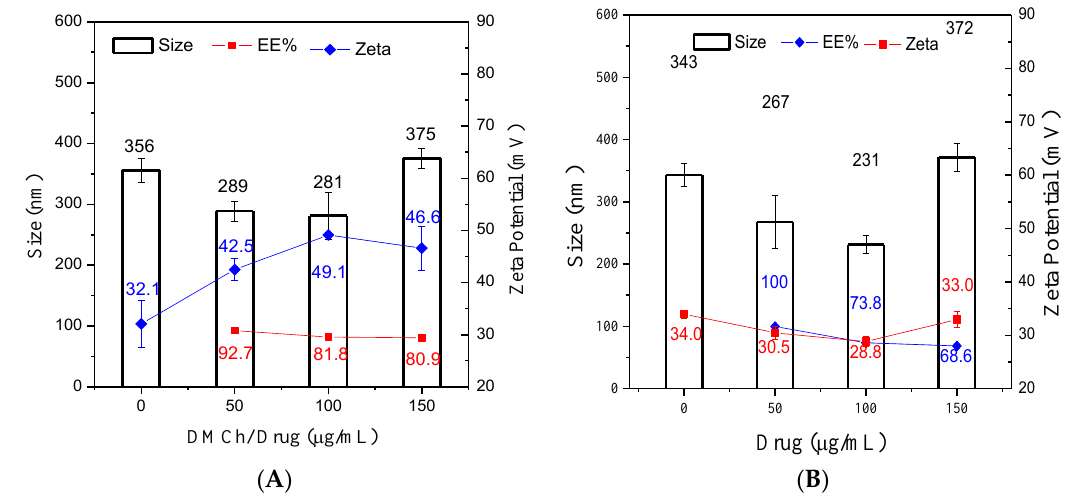
Figure 4. ( A ) the particle size, zeta potential, and encapsulation efficiency of micelles DMCh-CUR and ( B ) DMCat-CUR with different drug concentrations.